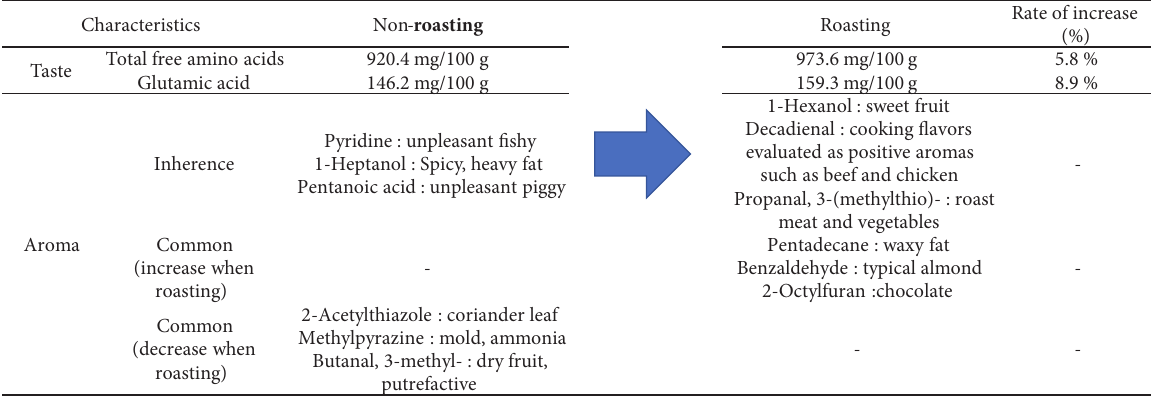
Figure 4: Summarised positive effects of convection heated roasting extraction in sauce